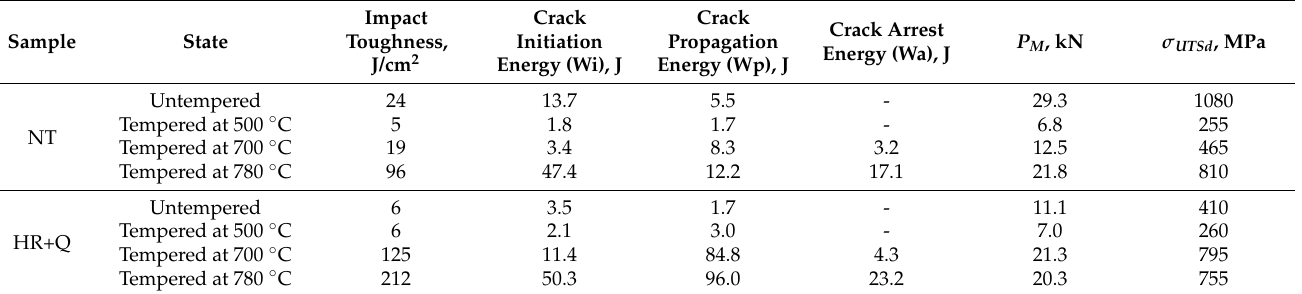
Table 3. Impact toughness, the energies absorbed at different crack propagation stages and dynamic parameters calculated from load–deflection